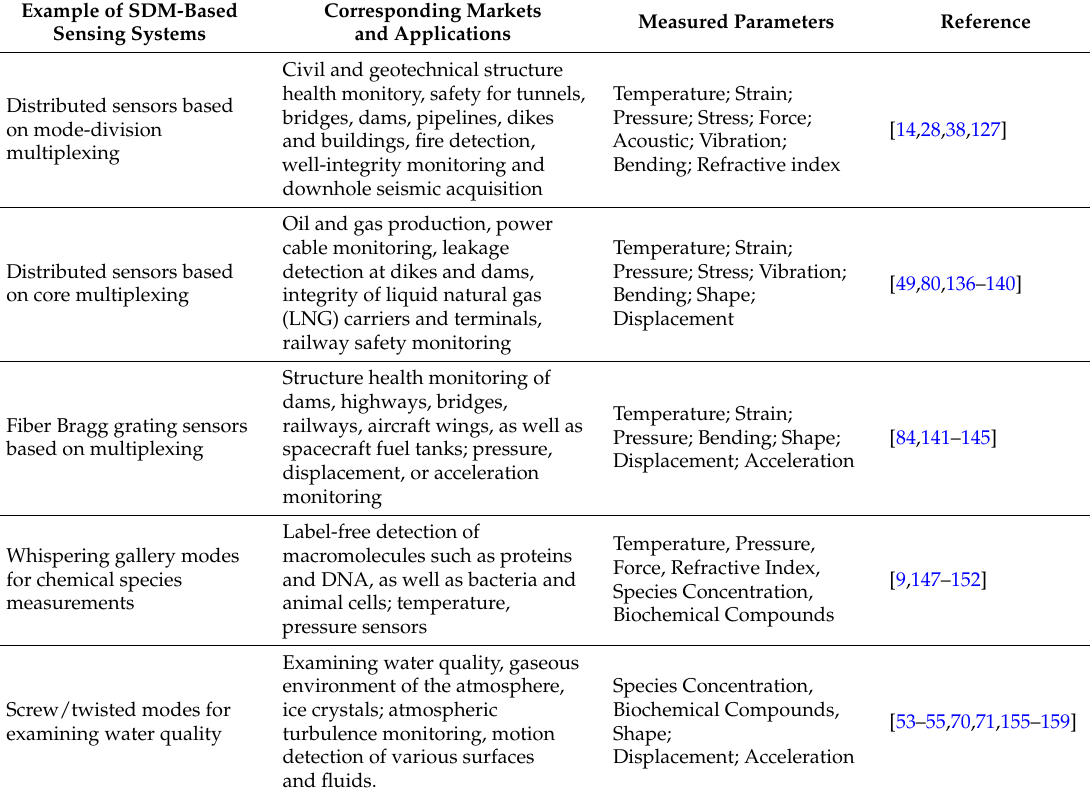
Table 4. SDM sensing systems for various markets and